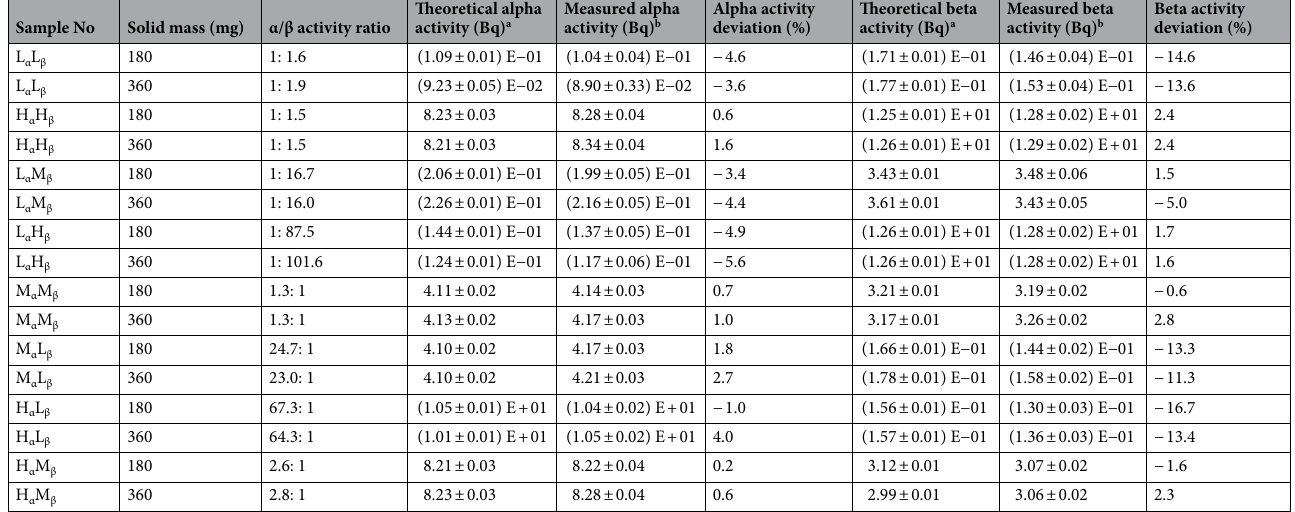
Table 6. Validation results of mixed spiked samples of 241 Am, and 90 Sr/ 90 Y standard solution in simulated saline water. a Data obtained by multiplying the activity of the standard solution and the mass added. The expanded uncertainty corresponds to k = 1. b The expanded uncertainty corresponds to k = 1.